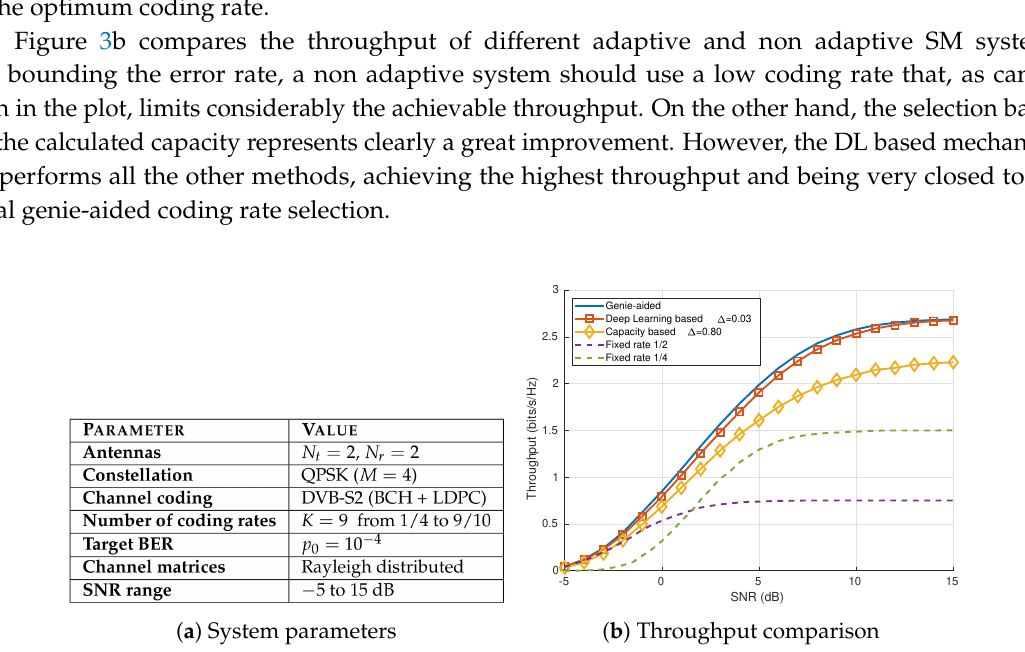
Figure 3. System parameters, classification performance of the DL-based coding rate selection and throughput obtained with different adaptive and non adaptive SM coding rate selection